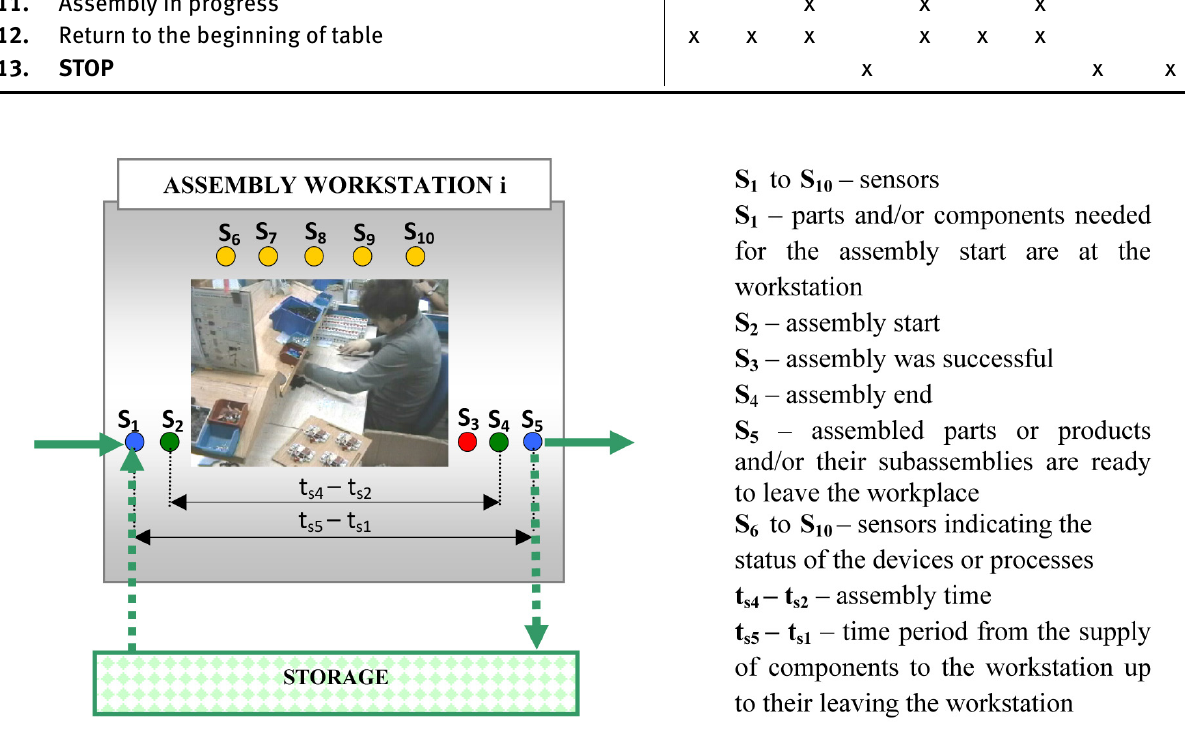
Certain parameters are then monitored during the on- ures and their causes. In the long run it will enable the ob- line analysis. These include, but are not limited to the tainment of relevant data for failure analysis and perhaps number of parts between workstations, exceeding of the information about reasons for delays. Figure 2a) shows a defined times, data about product errors and about fail- diagram of the analysis of 3 linked assembly